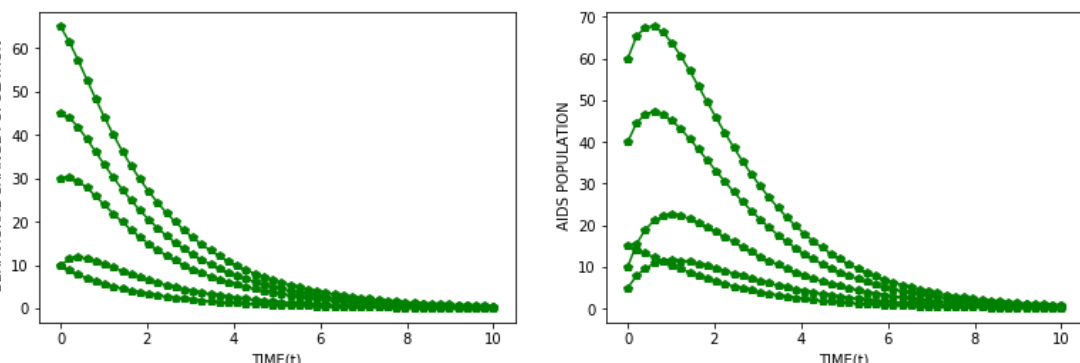
Fig. 6 and Fig. 7 Showing The Behavior of Both Fast Progression and AIDS Populations when R T is Less Than